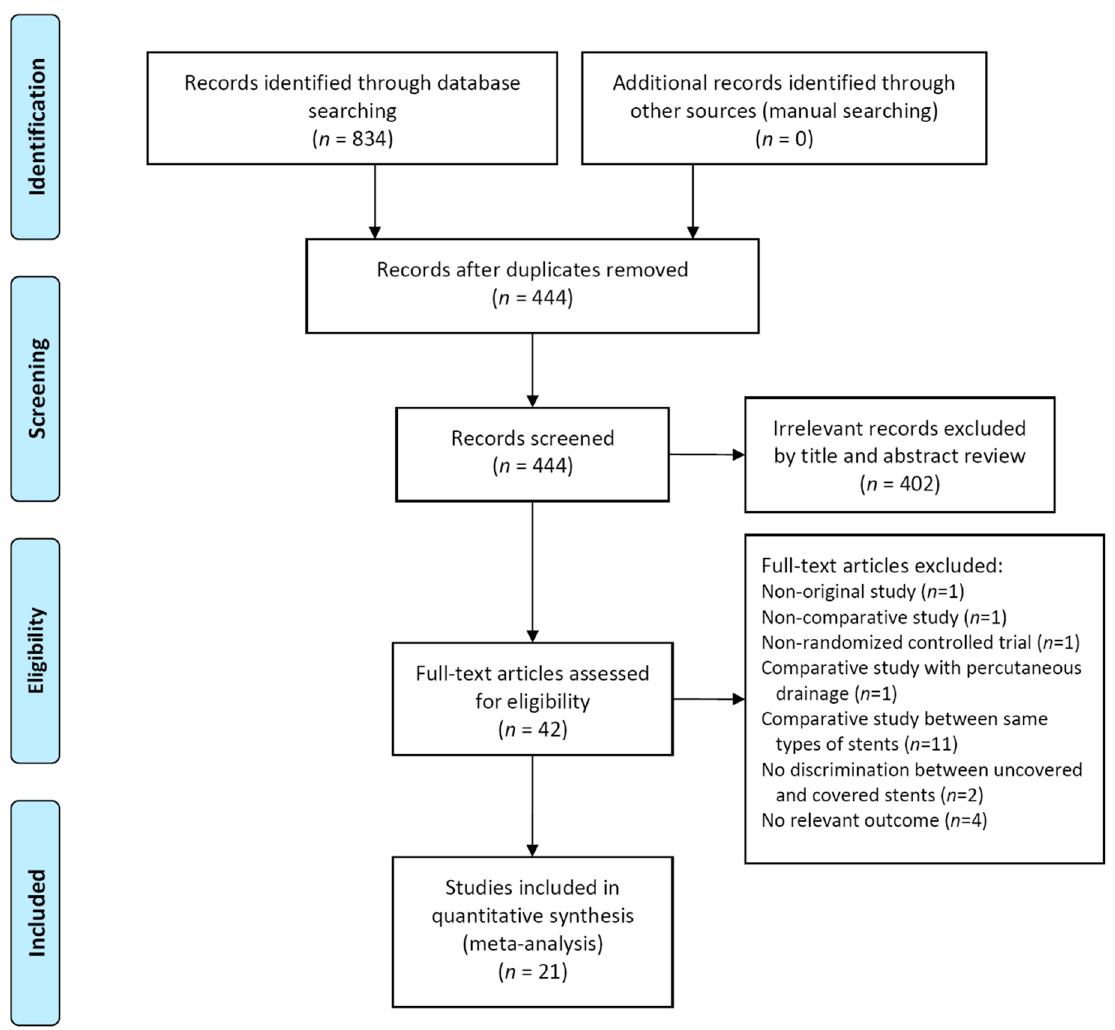
Figure 1. Flow diagram of the studies included in the meta ‐ analysis.